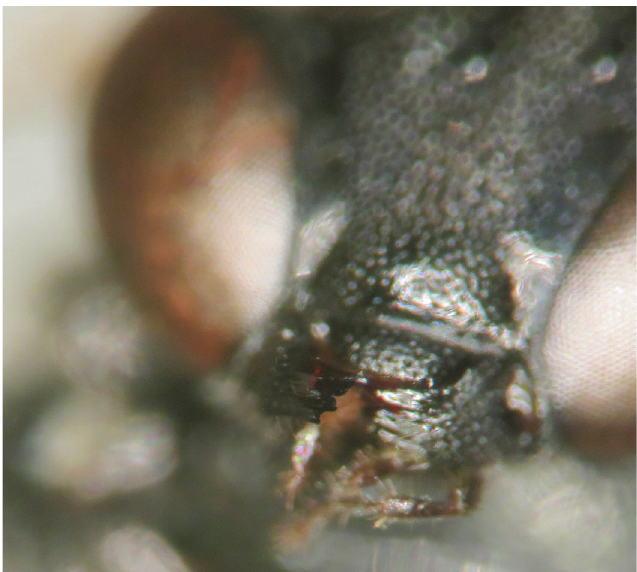
Figure 8. Heinrichiella obscura comb. n., mandibles, labrum, clypeus